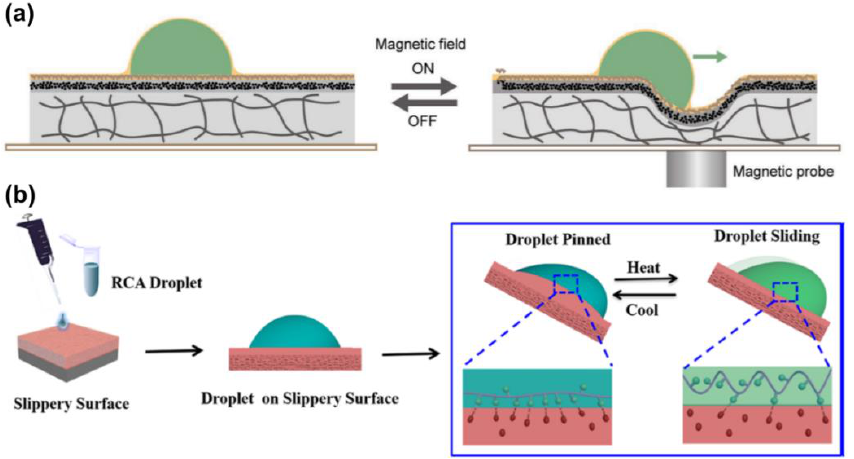
Figure 15 . ( a ) Mechanism of the slippery surface to drive droplets by a magnet probe. Reproduced with permission [52] . Copyright 2019, Wiley-VCH. ( b ) Thermally control RCA biological droplet sliding behavior on the LIS. Reprinted with permission from [67]. Copyright (2019) American Chemical Society .